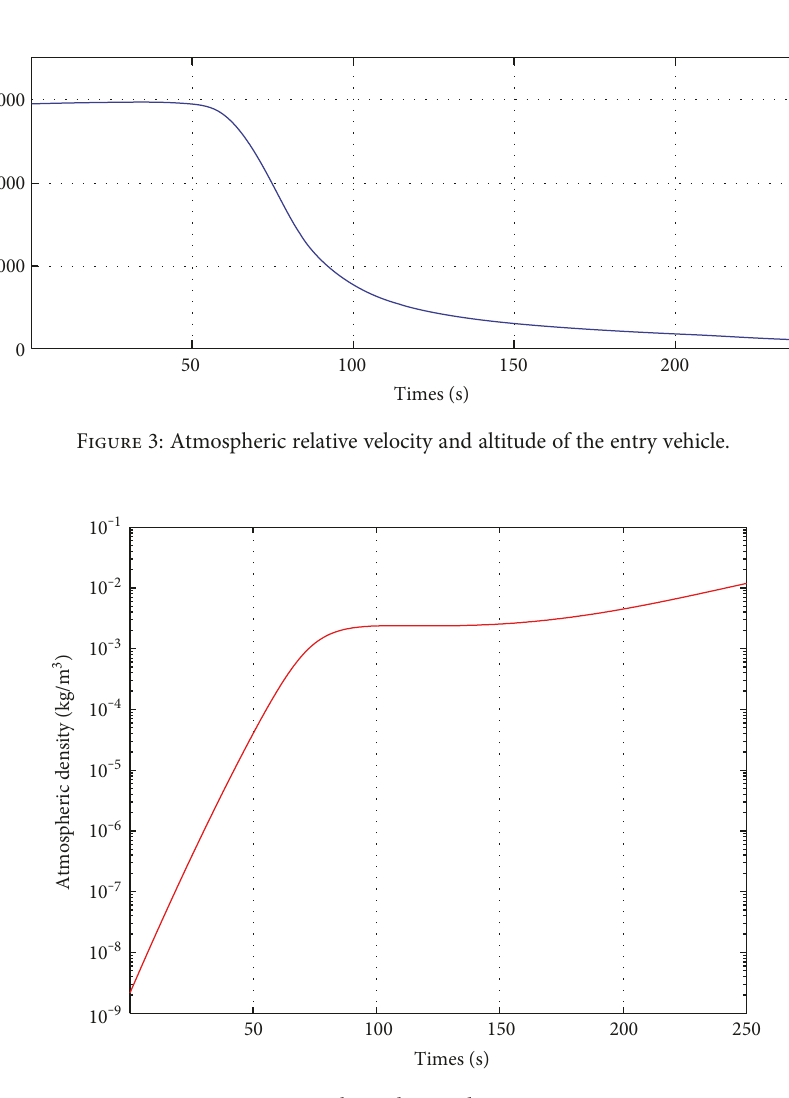
Figure 4: Atmospheric density during Mars